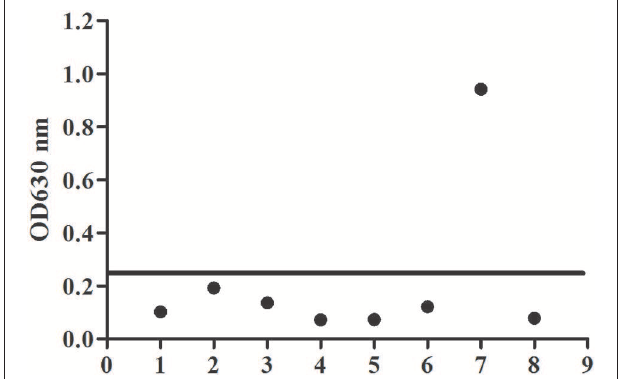
FIGURE 4 | Determination of specificity of BgGPI47-WH-ELISA. Lane 1: Strongyloides stercoralis -infected dog sera; lane 2: Dog hydatid-infected dog sera; lane 3: Canine parvovirus-infected dog sera; lane 4: Canine rabies virus-infected dog sera; lane 5: Toxoplasma gondii -infected dog sera; lane 6: Babesia canine -infected dog sera; lane 7: Positive control; lane 8: Negative control.